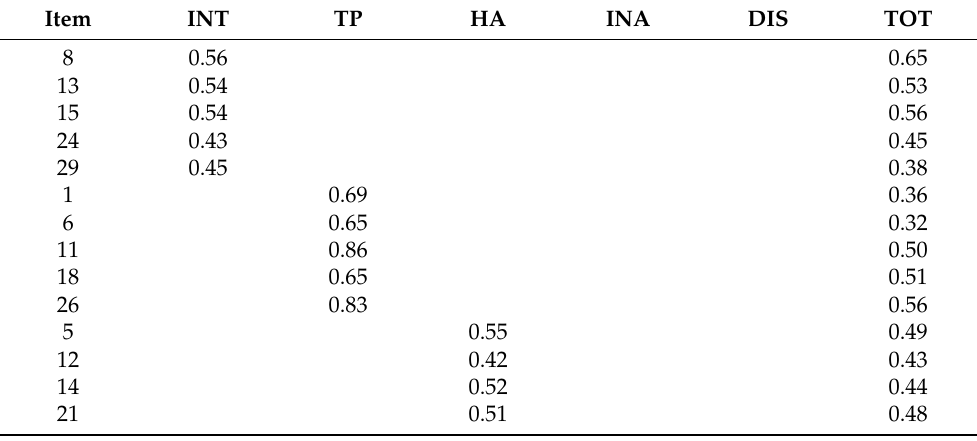
Table 7. Item-rest correlations and McDonald’s omega ( ω ) coefficients for the single factors and the MSBS as a